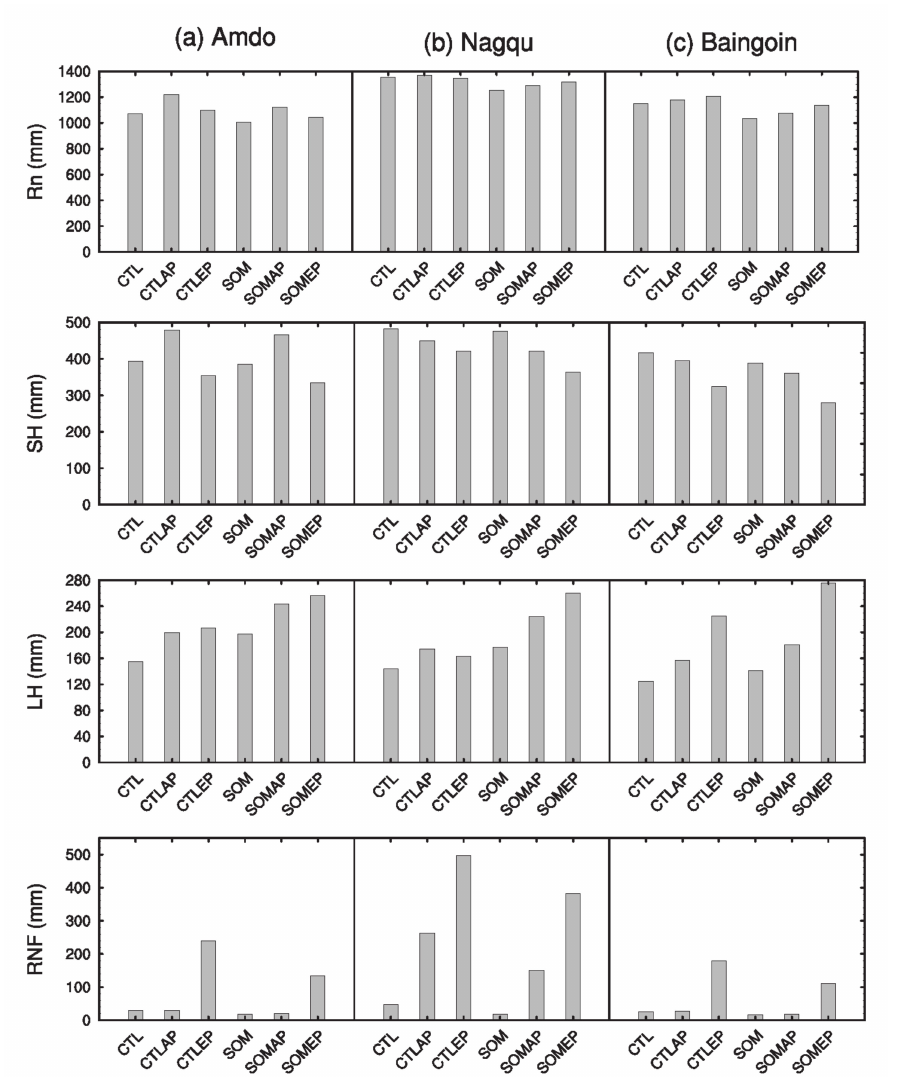
Figure 13. Annual amount of surface energy and runo ff (water equivalent unit) for the period 2014–2015 simulated by Noah-MP in all sensitivity tests: ( a ) net radiation, ( b ) sensible heat flux, ( c ) latent heat flux, and ( d ) total runo ff